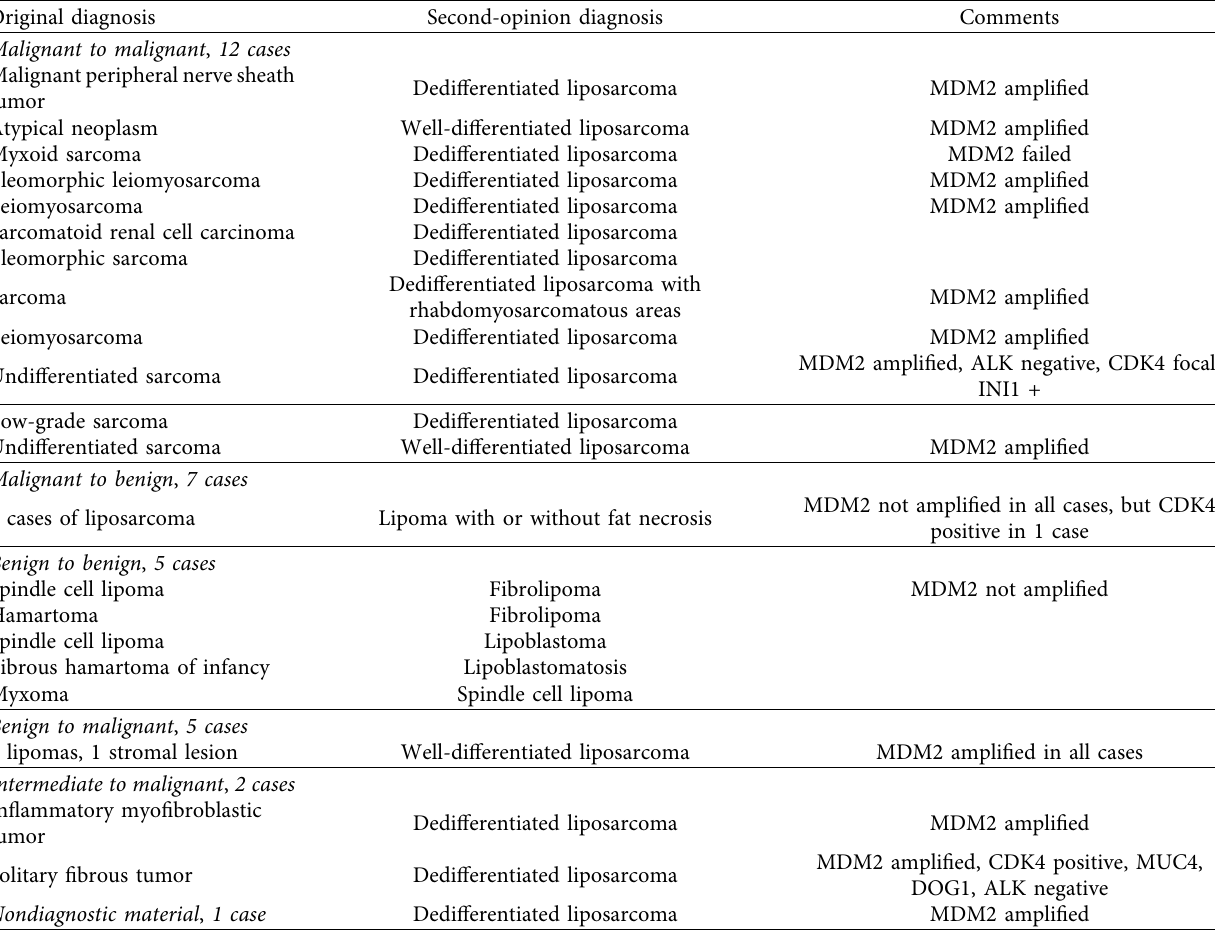
Table 3: Adipocytic tumors with discrepancy in opinion.